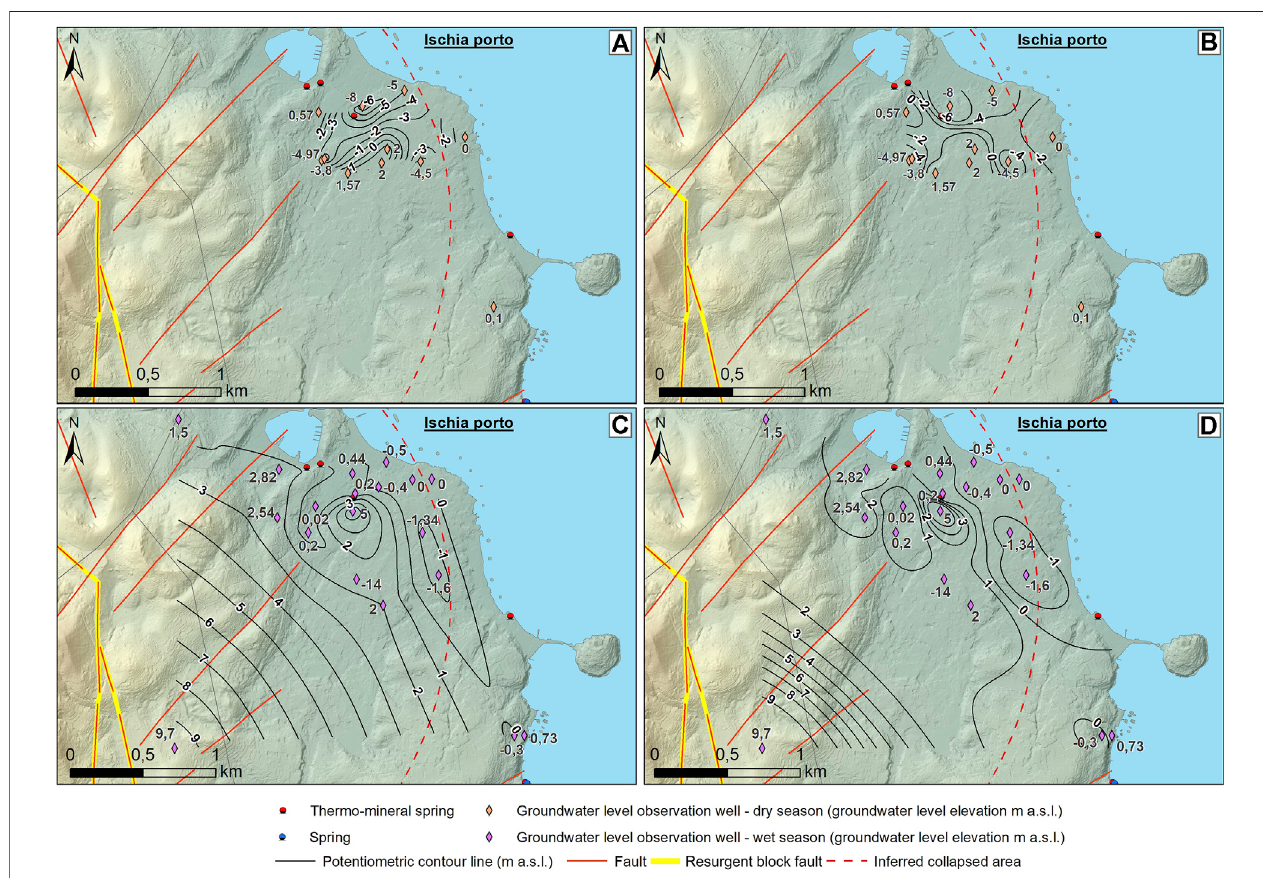
FIGURE 9 | Piezometric surface map of the Ischia Porto sector: (A) NaN interpolation (dry season); (B) IDW interpolation (dry season); (C) NaN interpolation (wet season); (D) IDW interpolation (wet season). DEM details are in Figure 2 .